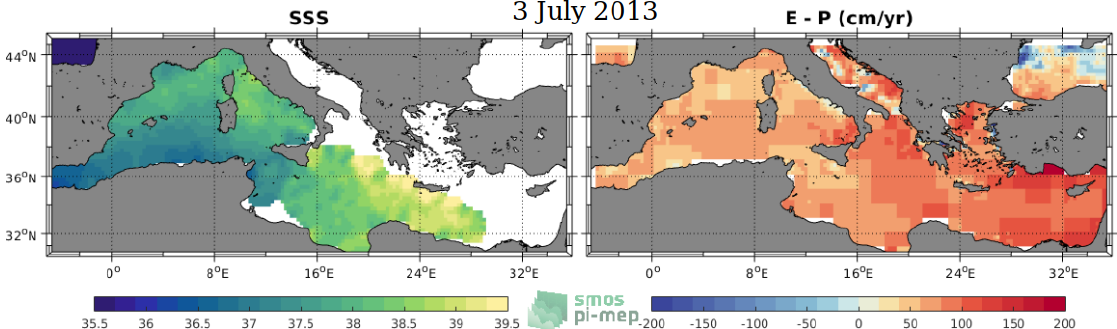
Figure 20. Satellite SSS (SMOS L3 MED-ATL-OA V2—9 DAYS (BEC)) and Evaporation (OAflux) minus precipitation (CMORPH) estimates in the Mediterranean